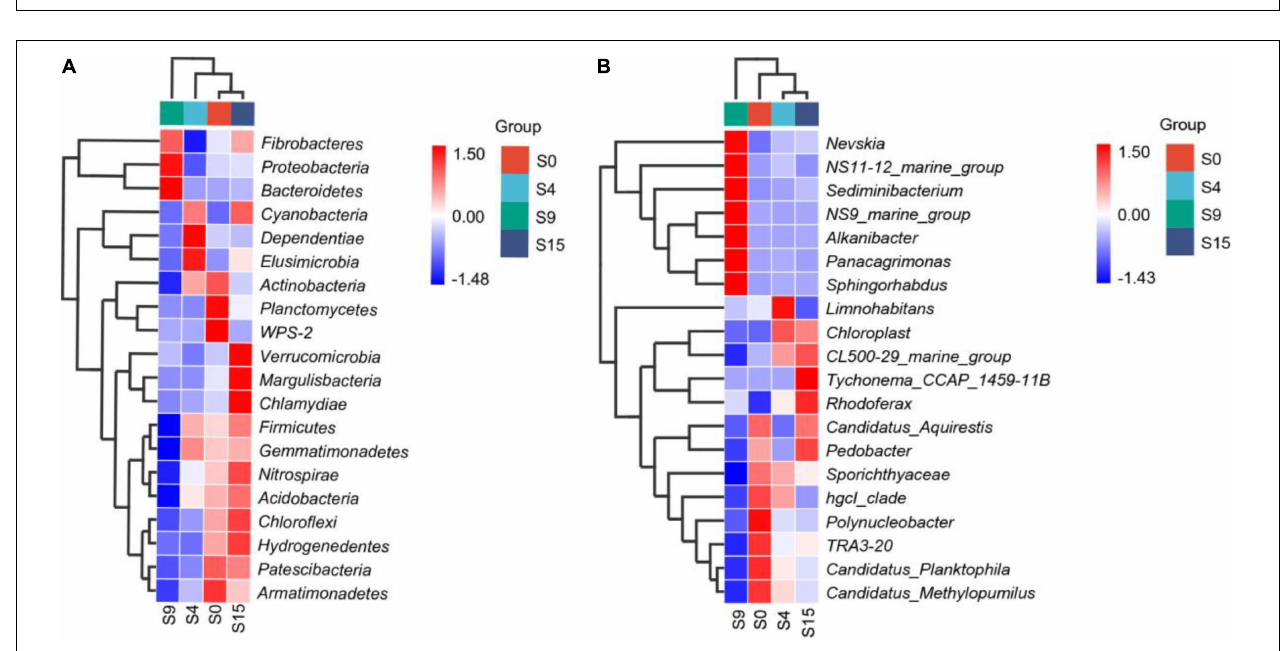
FIGURE 6 | Distribution of each sampling point at different phylum levels.